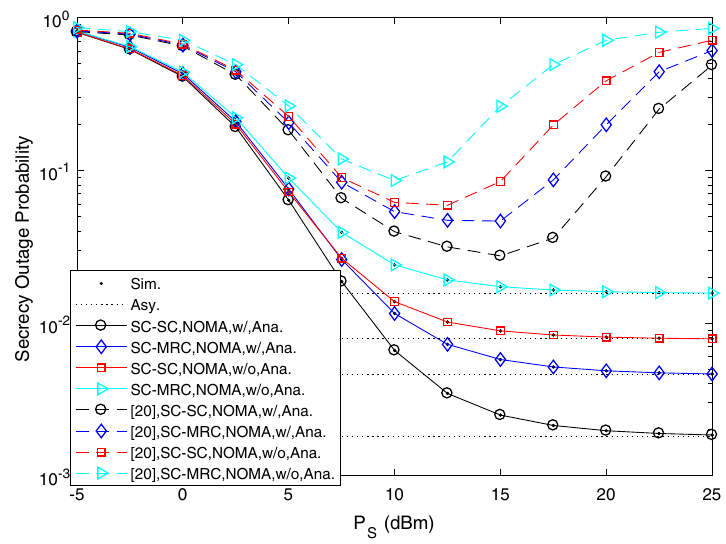
Fig. 3 The theoretical results and simulation results of SOP versus transmit power. The SOP of the four cases for NOMA VS